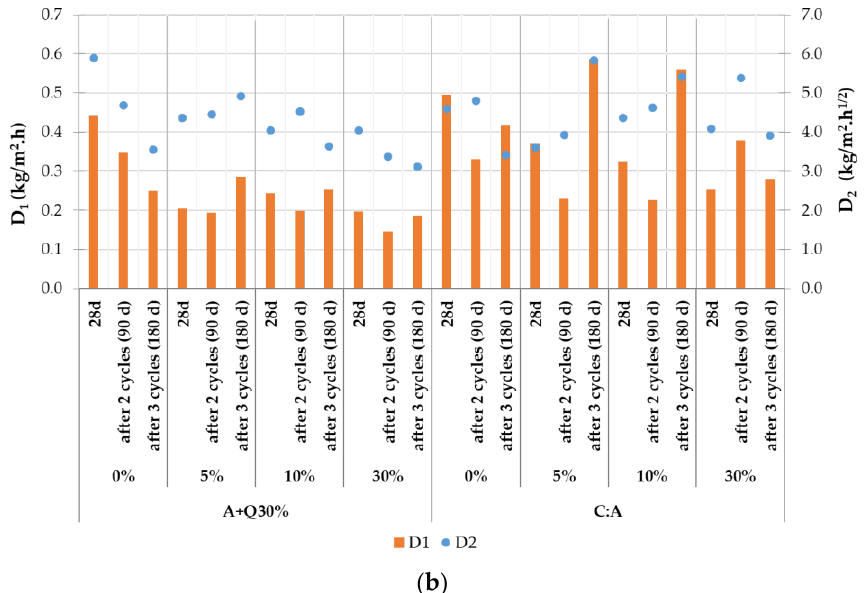
Figure 13. Hydric properties of the mortars with fine-tuning of the aggregate, after cycles of the water absorption: ( a ) water absorption; ( b ) water desorption.